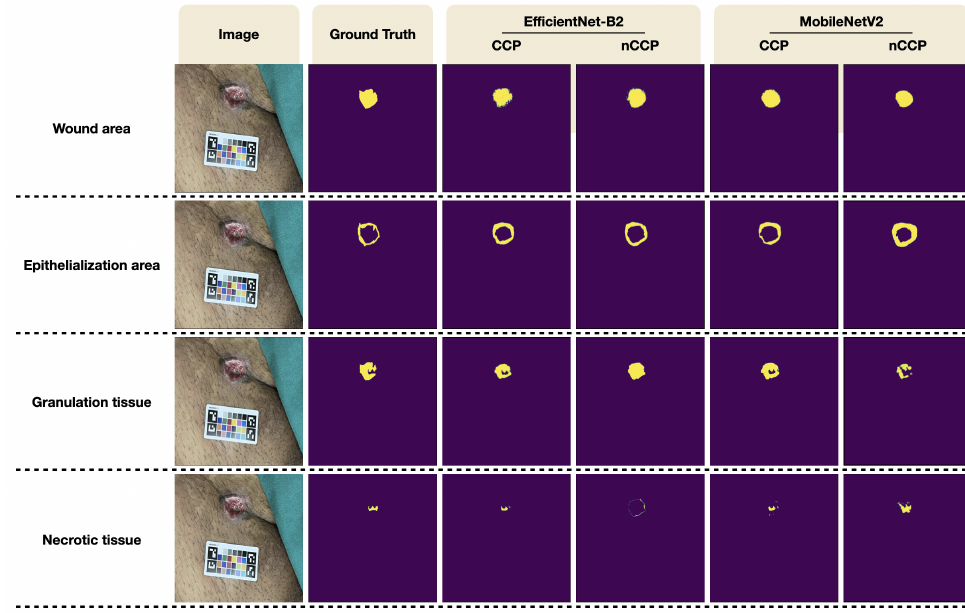
Figure 9. Qualitative segmentation results from our proposed method.